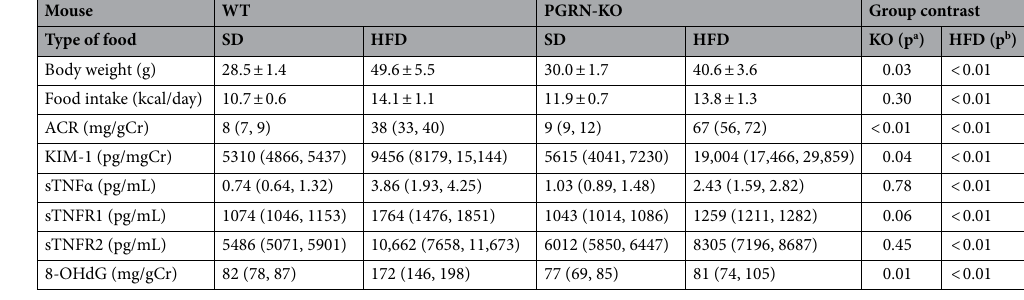
Table 1. General and biochemical parameters of experimental groups after 12-weeks of HFD. Two-way ANOVA was used to evaluate the individual effects of the presence/absence of PGRN and diet type. Body weight, food intake, and ACR: n = 6–7/group; KIM-1, sTNFα, and sTNFR2: n = 8–11/group; sTNFR1 and 8-OHdG: n = 4/group. Data are expressed as means ± SD or median (quartiles). ACR albumin/creatinine ratio, sTNFα serum TNFα, sTNFR1 serum TNFR1, sTNFR2 serum TNFR2, WT wild-type C57BL/6 J, KO PGRN homozygous knockout, HFD high-fat diet. a By ANOVA to determine the effect of PGRN status. b By ANOVA to determine the effect of diet type.